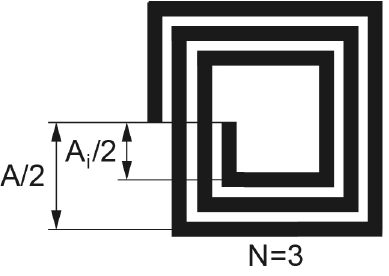
Figure 2: The layout of a square planar spiral coil of three windings ( 𝑁 = 3 ) used by Jenei et al.